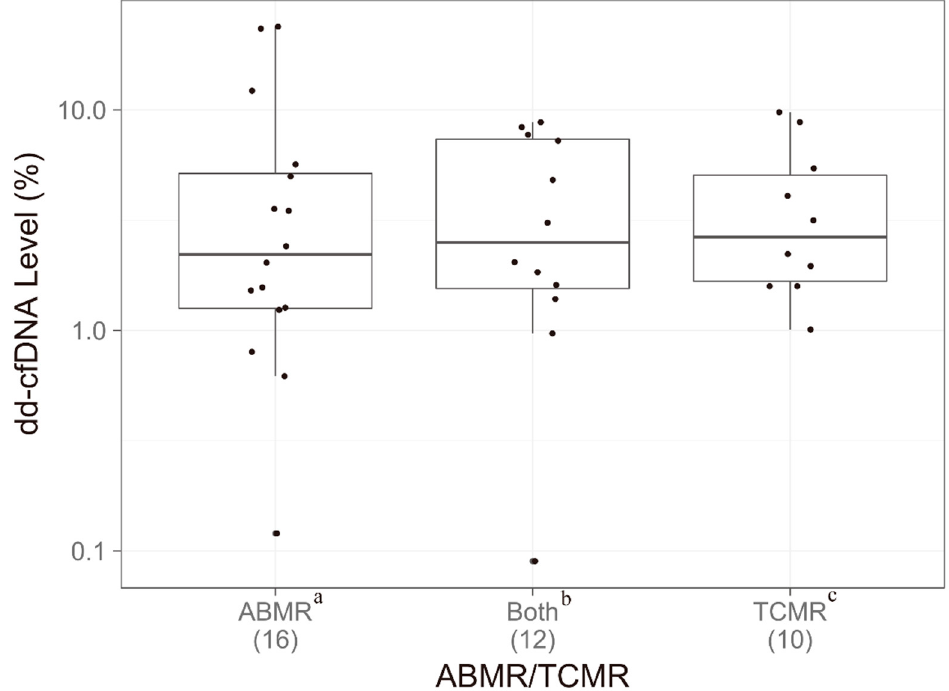
Figure 5. dd-cfDNA as a function of antibody-mediated—versus T-cell—mediated rejection. Boxes indicate interquartile range (25th to 75th percentile); horizontal lines in boxes represent medians; dots indicate all individual data points. p -values for dd-cfDNA adjusted using Kruskal–Wallis rank sum test. a Samples assigned ABMR or ABMR and bTCMR. b Samples assigned ABMR and TCMR. c Samples assigned TCMR or TCMR and bABMR. ABMR, antibody-mediated rejection; TCMR, T-cell-mediated rejection.